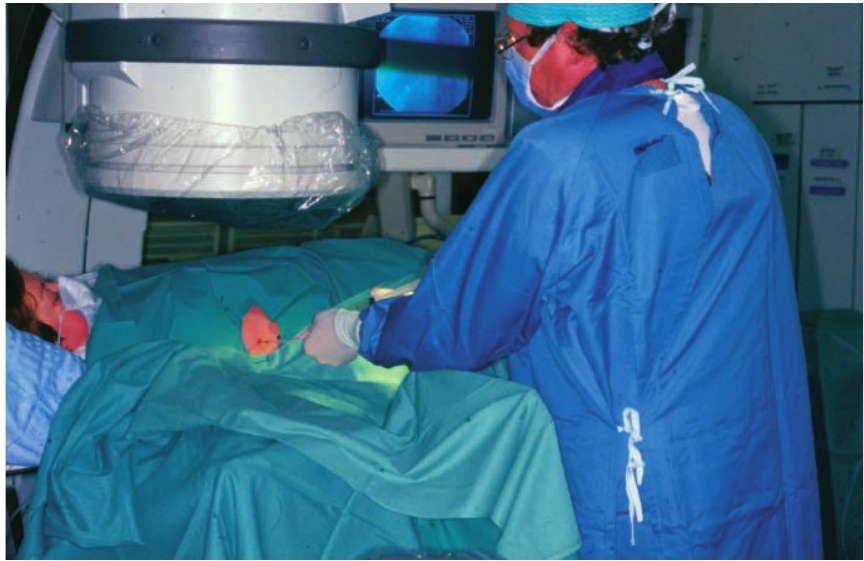
Transhepatic percutaneous injection of islets of Langerhans is a minimally-invasive procedure. The injection is performed under local anaes- thesia using interventional radiology techniques. The portal vein is accessed under angiographic guidance (figure 3), and the purified islet sus- pension is slowly infused into the vein with continuous monitoring of the intraportal hydrostatic